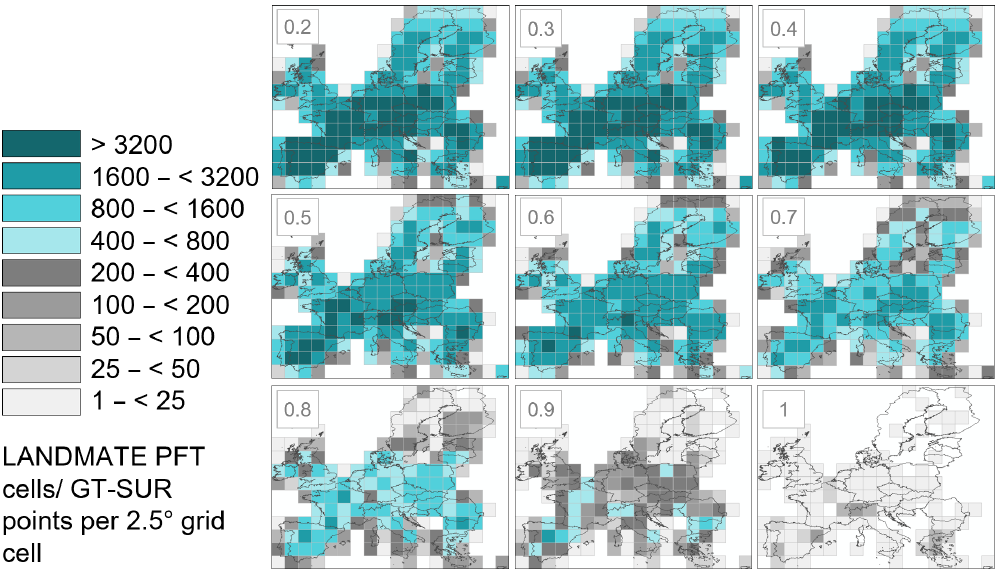
Figure 5. The distribution of the LANDMATE PFT cells grouped by threshold for minimum coverage of the respective dominant LULC type over the research area in Europe. The same number of LANDMATE PFT cells falls into the groups with minimum coverages of 0.1 and 0.2. Therefore, the 0.1 group is not shown in the